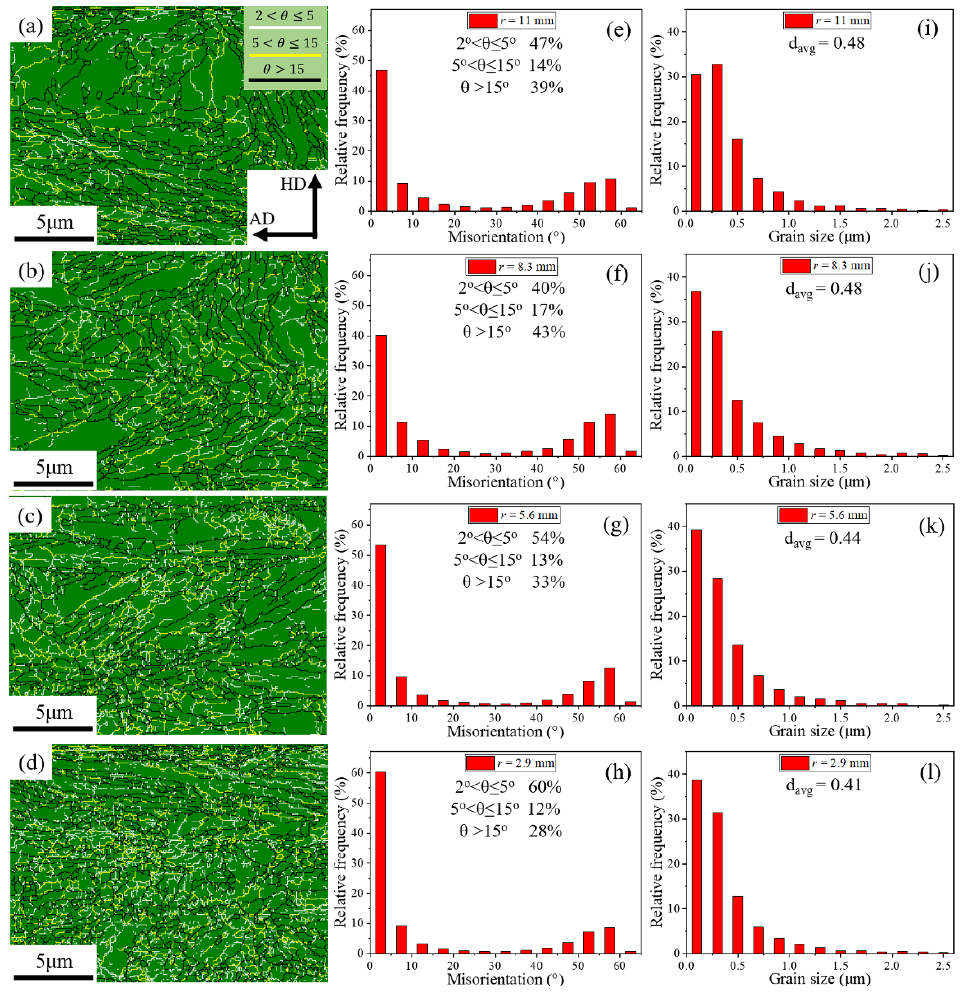
Figure 5. Grain boundary maps of the forged tube with a reduction of 42.7%: ( a , e , i ) r = 11 mm; ( b , f , j ) r = 8.3 mm; ( c , g , k ) r = 5.6 mm; ( d , h , l ) r = 2.9 mm. Table 3. Grain boundary fraction and AGS of the forged tube with a reduction of